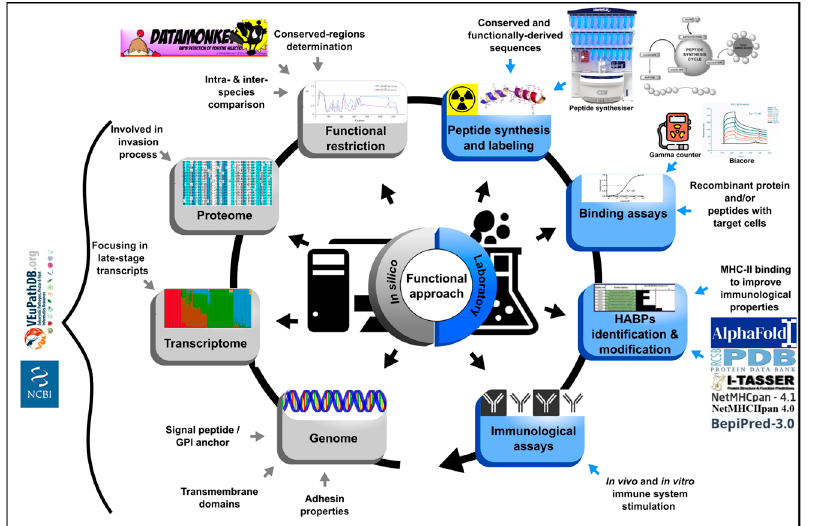
Figure 3. Functional approach strategy. Flow diagram describing the steps for prioritising in silico selection and laboratory experiments for identifying ideal vaccine component peptides. The strategy involves identifying the entire gene repertoire (using genome, transcriptome and proteome data mining) and their encoding sequence analysis by bioinformatics tools based on in silico characteristics and their intra (from 5 genomes)- and inter-species (phylogenetically related) conservation level [73]. Peptides encoded by regions under functional constraint are then chemically synthesised and target cell binding activity must be tested by radio-iodination-based peptide-cell interaction and competition assays [22]. Identified HABPs must be evaluated in in vitro culture and then modified to fit inside MHC-II to evaluate their role as vaccine component in in vivo tests in the pertinent experimental model. The figure shows the required resources for carrying out the functional approach.